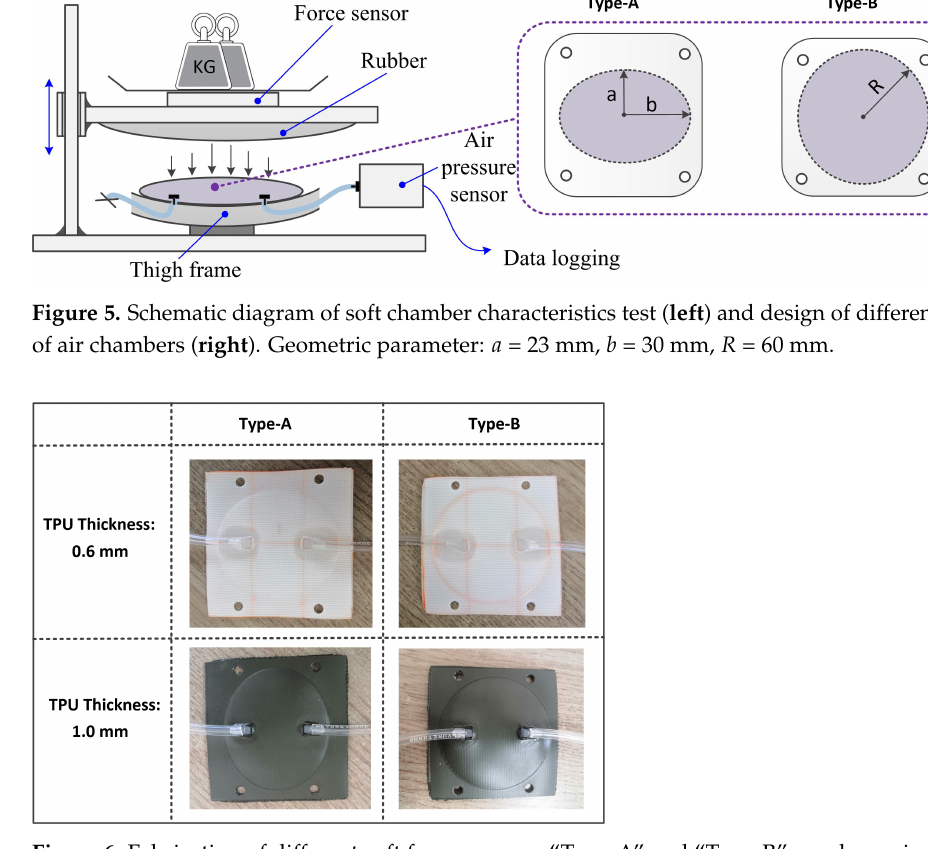
Figure 6. Fabrication of different soft force sensors. “Type-A” and “Type-B” are shown in Figure 5. The two fabric-based TPU materials are